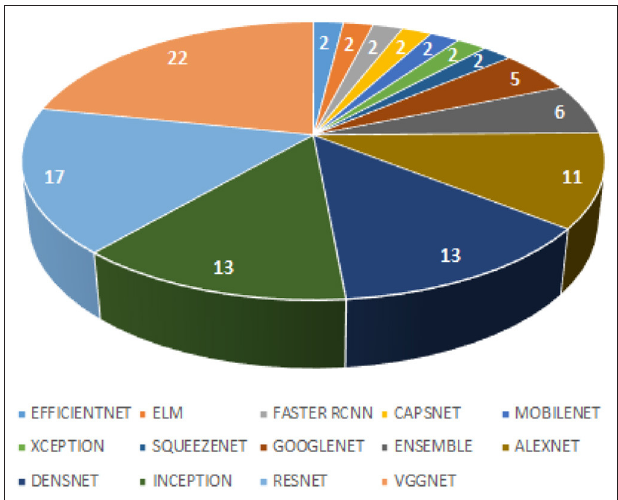
FIGURE 4 | Hierarchical chart of computational techniques according to the frequency of